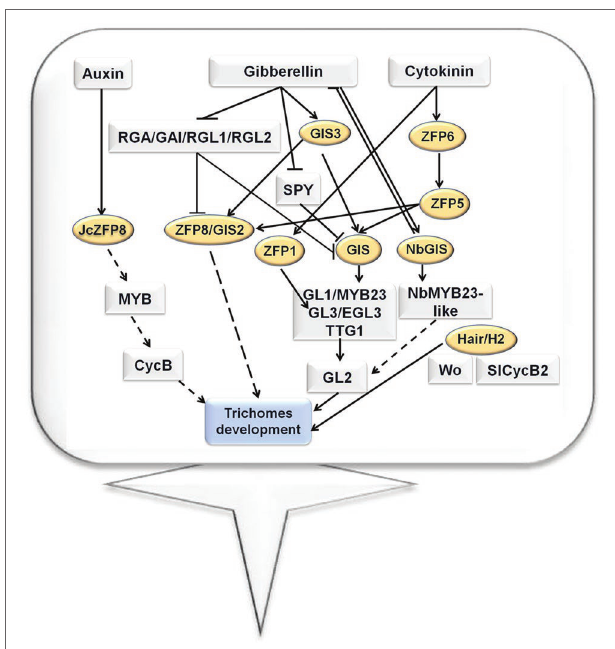
FIGURE 1 | Trichome development regulatory network involving the C2H2 zinc finger proteins in Arabidopsis, tomato, and tobacco (Yan et al., 2014; Sun et al., 2015; Chang et al., 2018; Shi et al., 2018a; Zhang et al., 2020; Chun et al.,